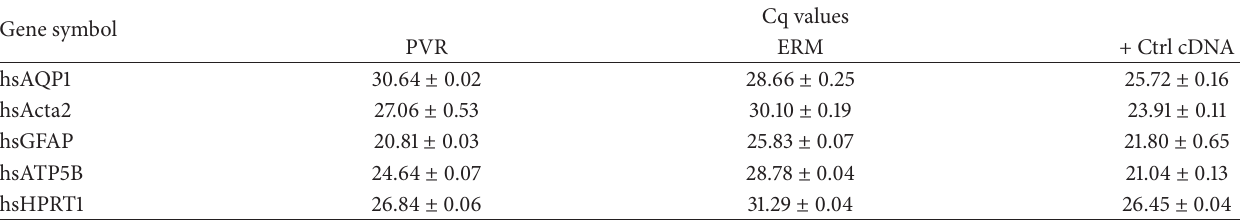
Table 3: RT-qPCR Cq values of the tested genes in both PVR and ERM pools. Quantification cycles (Cq) were determined in duplicate in both PVR and ERM pools of samples. Data are expressed as the mean ± S.E.M. of the duplicate